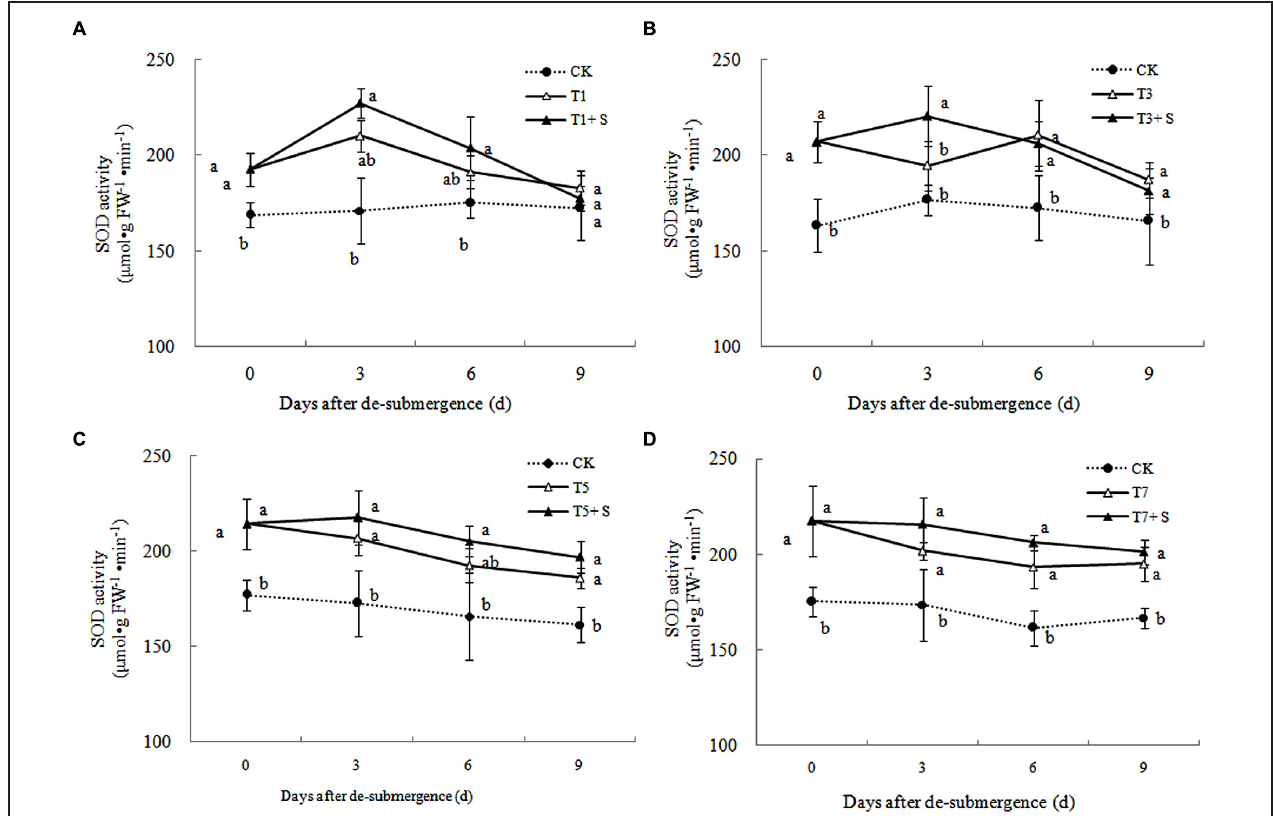
FIGURE 10 | Effects of Spd on superoxide dismutase (SOD) activity of rice after submergence.